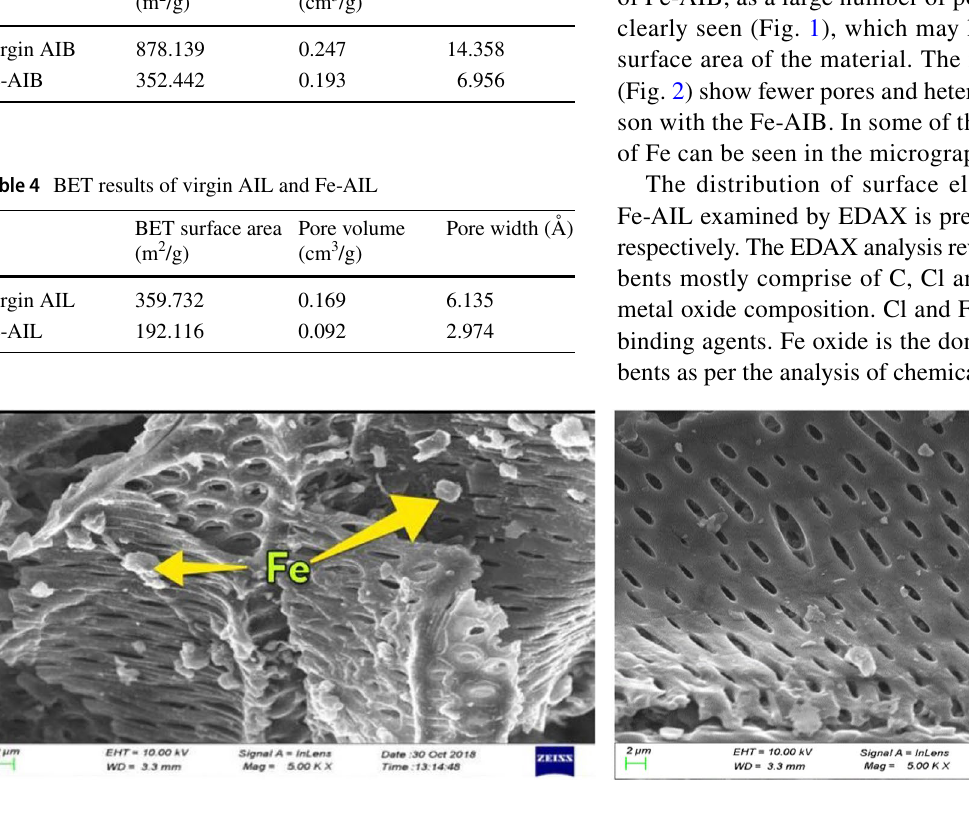
Fig. 1 SEM micrograph of Fe-AIB